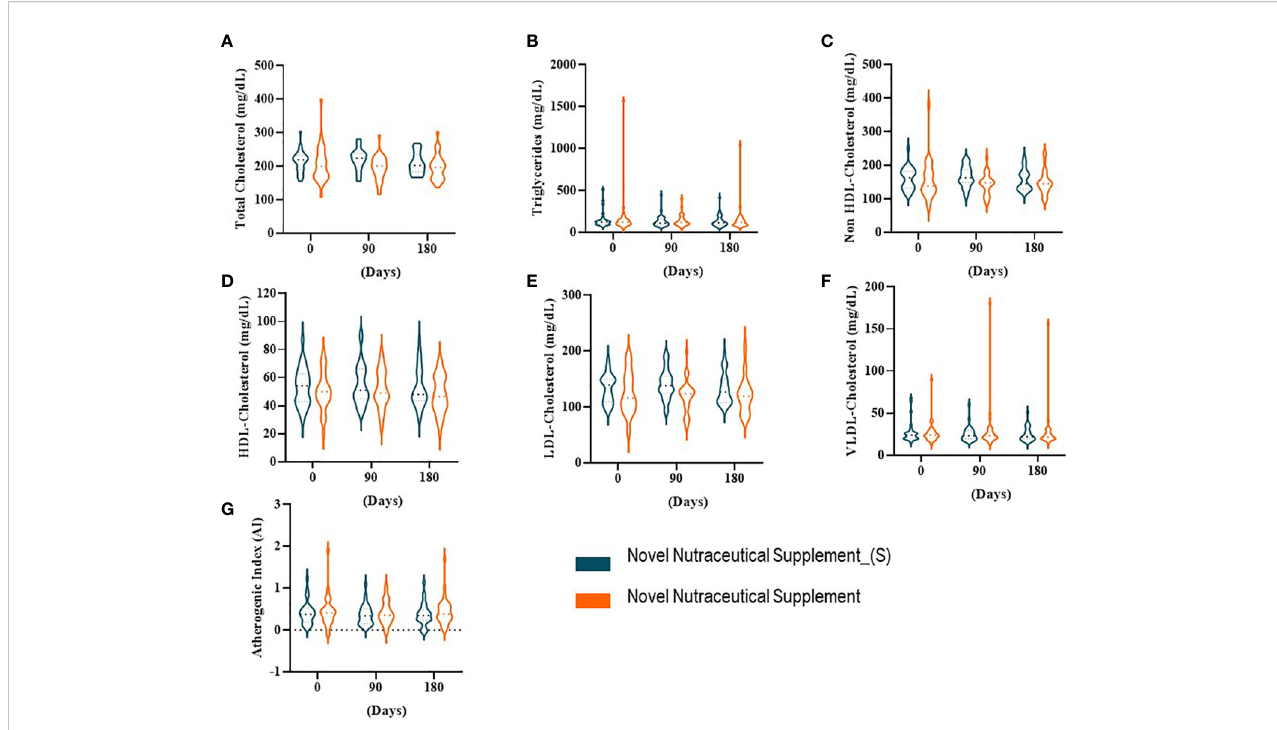
FIGURE 2 Lipid pro fi le at baseline time (Day 0) and 90 and 180 days post-supplementation. (A) Total cholesterol. (B) Triglycerides. (C) Non-HDL-cholesterol. (D) HDL-cholesterol. (E) LDL-cholesterol. (F) VLDL-cholesterol. (G) Atherogenic index (AI). Novel Nutraceutical Supplement_(S) (n = 30) and Novel Nutraceutical Supplement (n = 29). Values are expressed as mean ± SEM or median (min to max, box plot) by plot violin graphic. HDL, high-density lipoprotein; LDL, low-density lipoprotein; VLDL, very-low-density